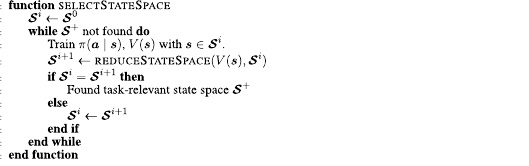
Algorithm 1. Pseudo code for relevant state selection.